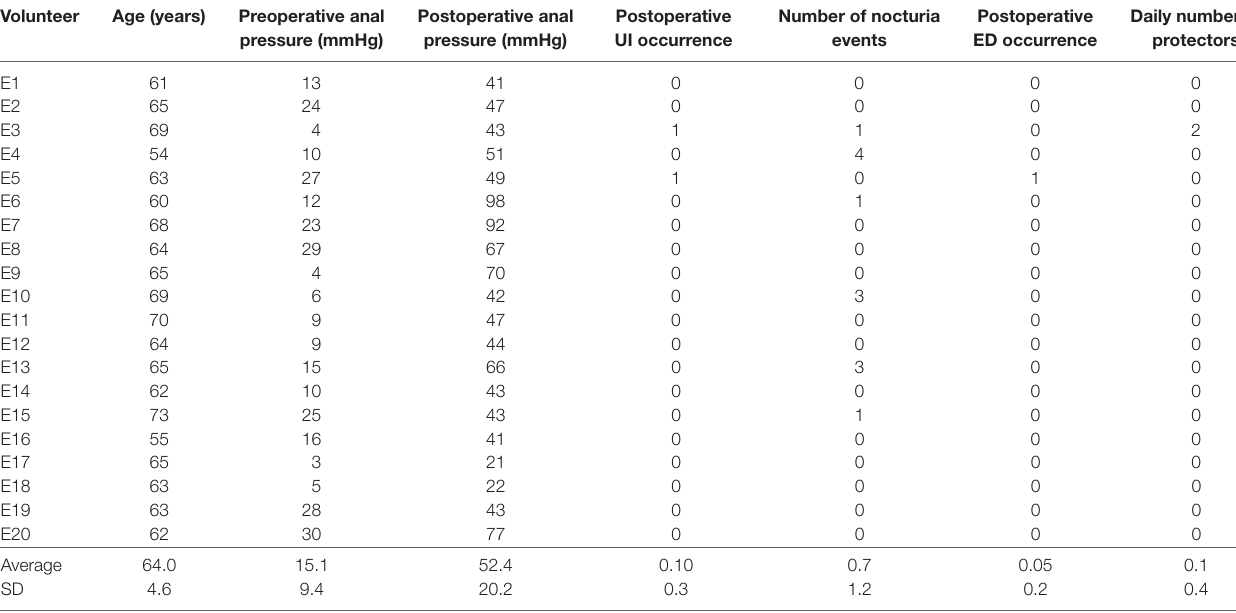
tABLe 2 | Experimental group’s measured data regarding age, anal pressures before and after prostatectomy, urinary incontinence (UI) occurrence after prostatectomy, number of nocturia events after prostatectomy, erectile dysfunction (ED) occurrence after prostatectomy, and daily number of protectors used by each patient (disposable underwear for male urinary